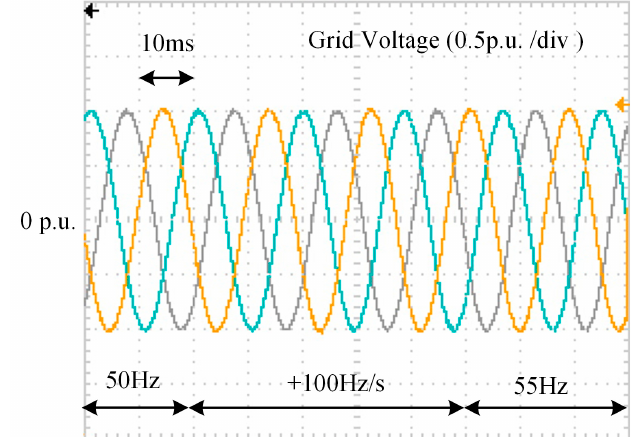
Figure 22. The experimental results of test case 2. ( a ) Estimated frequency and ( b ) phase error.